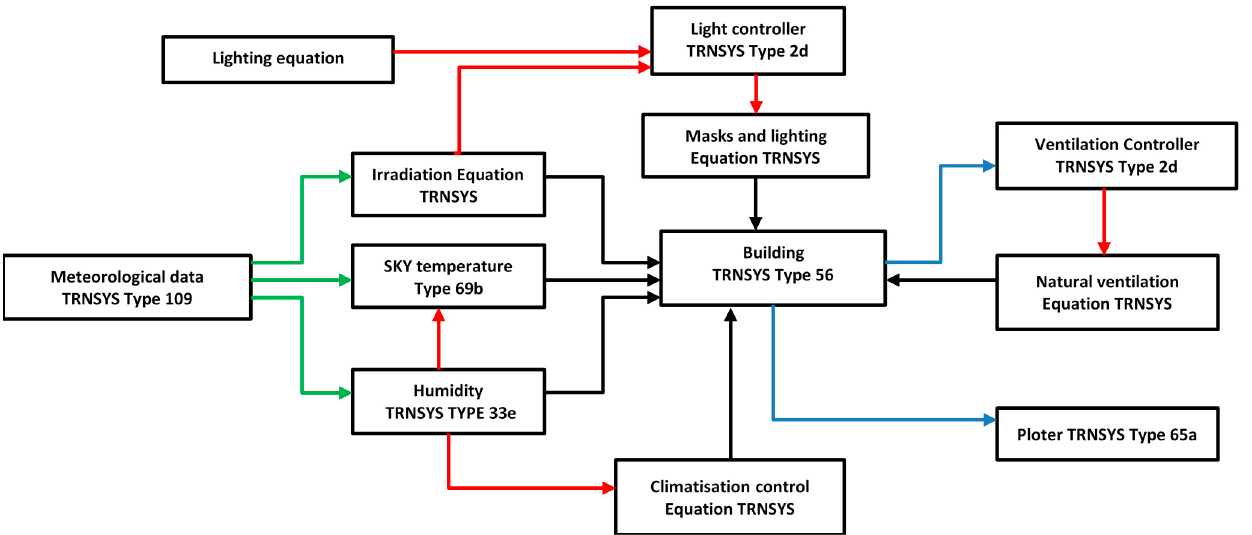
Figure 3. TRNsys information diagram for multi-zone building.